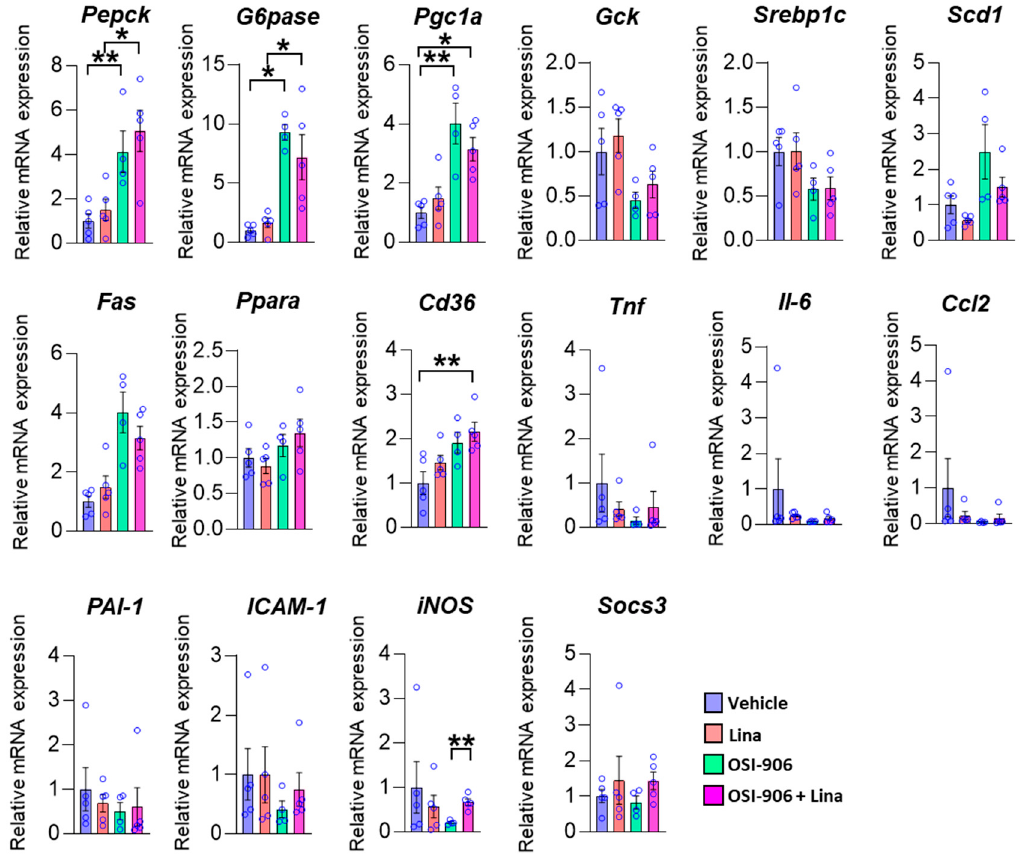
Figure 3. Hepatic gene expressions of the indicated molecules on day 7. Data represent the mean ± SEM. * p < 0.05, ** p < 0.01 ( n = 4–5 per group) by ANOVA with an additional Tukey–Kramer post-hoc test.